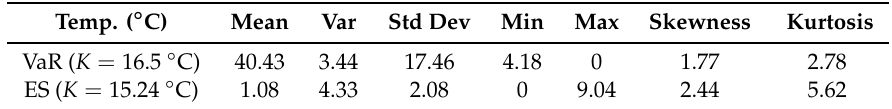
Tables A3 and A4 show descriptive statistics for June monthly HDD and CDD. Table A3. Descriptive Statistics for monthly HDDs for the period of time 1970–2016 and 10% percentile threshold.